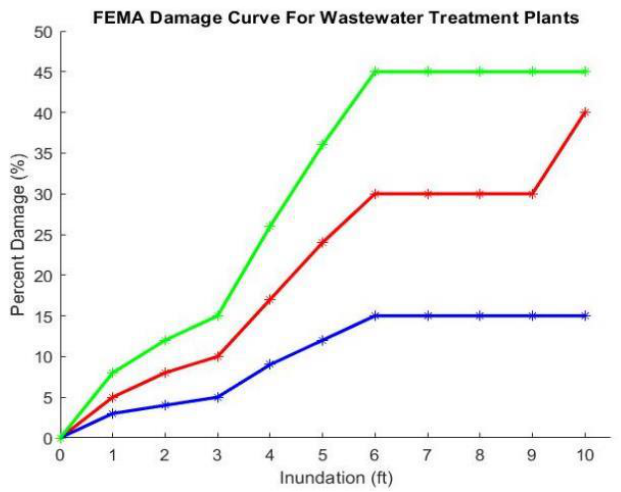
Figure 5. FEMA HAZUS flood damage curves for WWTF. Values are provided for the average (red) and less than average (blue) and more than average (green) vs. inundation levels [6,7]. The values given by * are taken directly from the FEMA HAZUS damage table for WWTF.